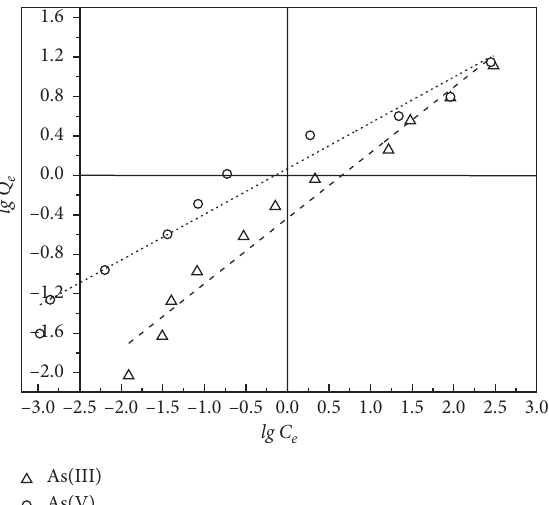
Figure 11: Freundlich model plots for the adsorption of As(III) and As(V) at pH � 8, adsorbent dosage 0.5g, and initial arsenic con- centration 1.3